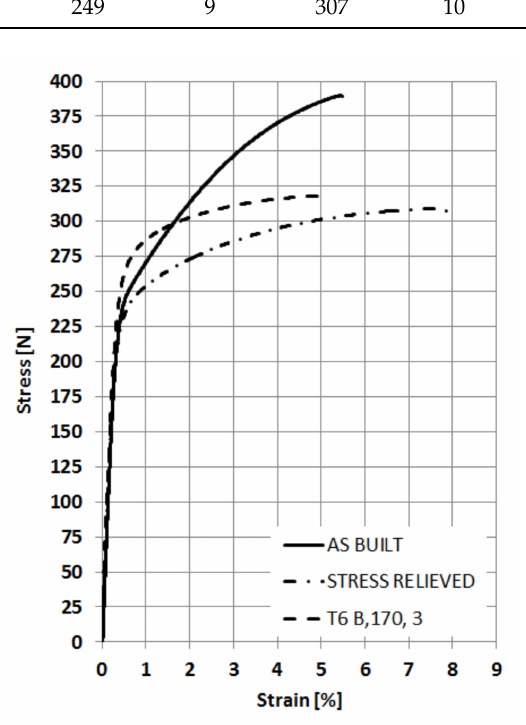
Figure 8. Stress–strain curves of room temperature tensile tests performed on A357 specimens by LPBF in di ff erent